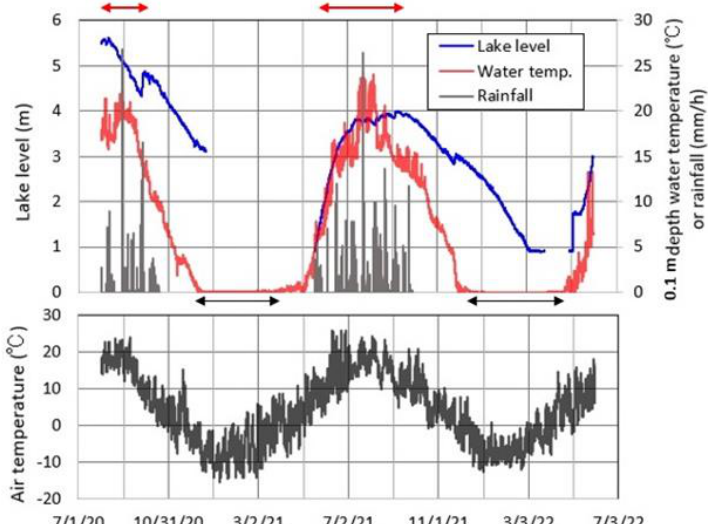
Figure 14. Temporal variations in hourly lake level, 0.1 m depth water temperature, rainfall, and air temperature at Okama for 31 July 2020–31 May 2022. The black arrows and red arrows show the completely ice-covered periods and the periods for calculating groundwater inflow and outflow.